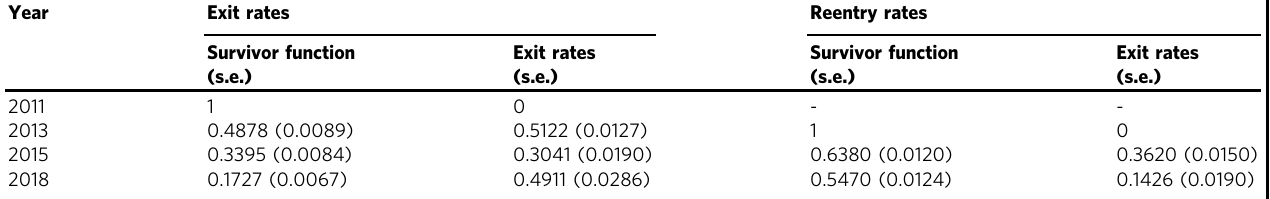
Table 6 The Kaplan – Meier estimates.